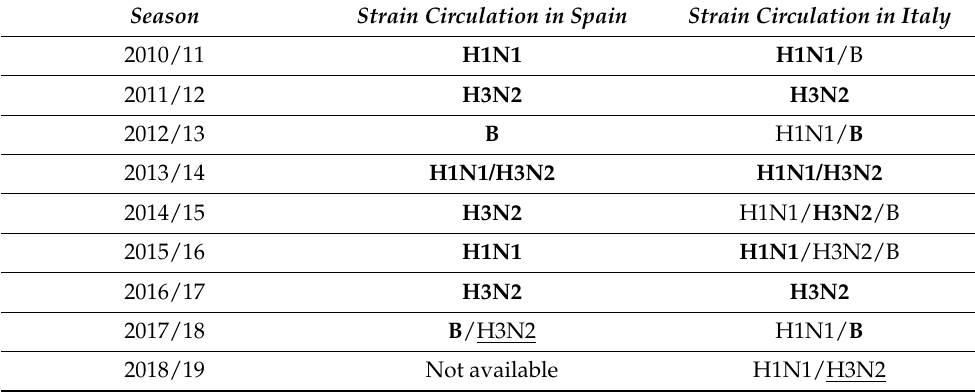
Table 1. Influenza strains for influenza seasons after 2010/11.